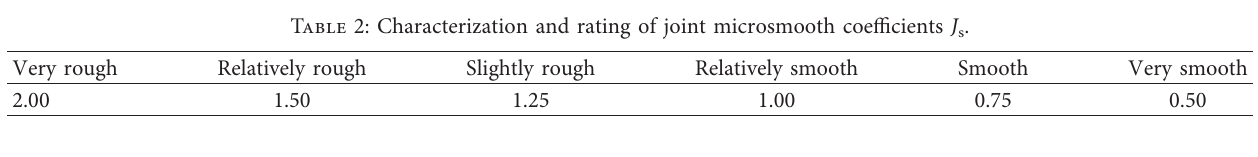
Table 3: Characterization and rating of joint alteration factor J